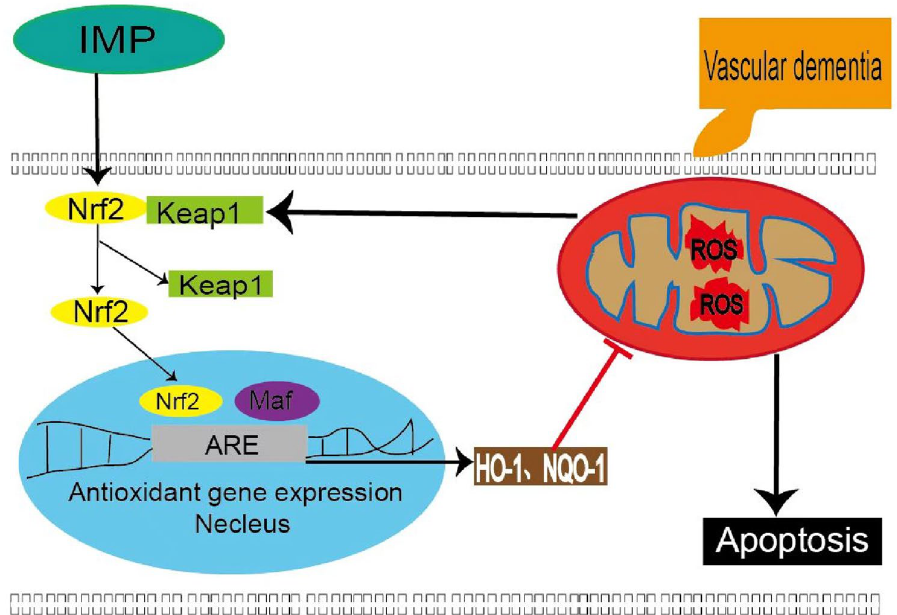
Figure 11. Schematic diagram of the antioxidative effect of imperatorin by regulating the Nrf2 signaling